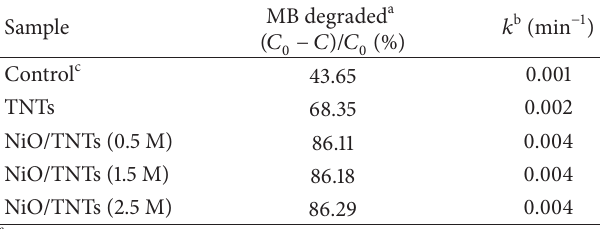
Table 3: Photodegradation of MB dye for TNTs and NiO/TNTs samples under solar light irradiation.